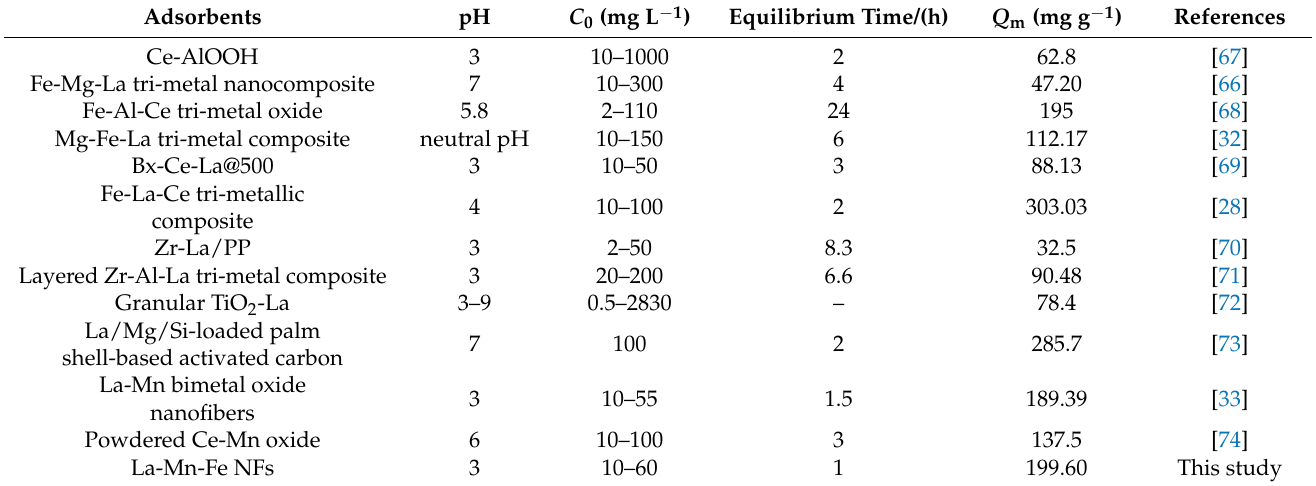
Table 2. Comparison of various adsorbents based on rare earth elements for